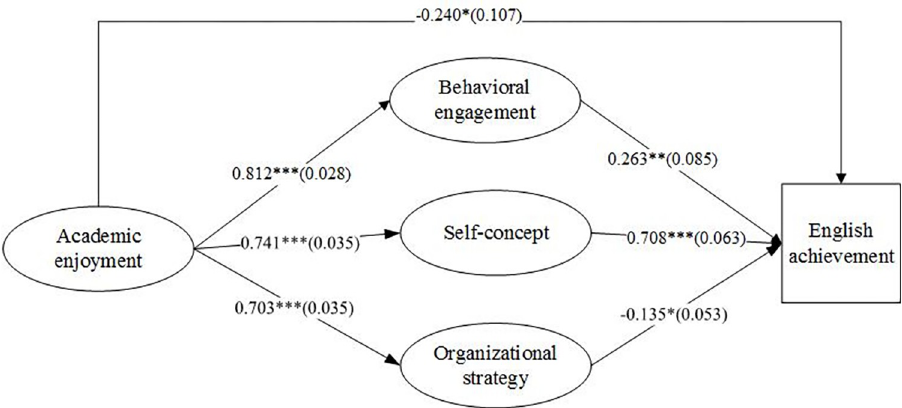
Fig 1. Multiple mediation models between academic enjoyment and English achievement. Note . Standardized path coefficients and standard error are presented. � p < 0.05, �� p < 0.01, ��� p <